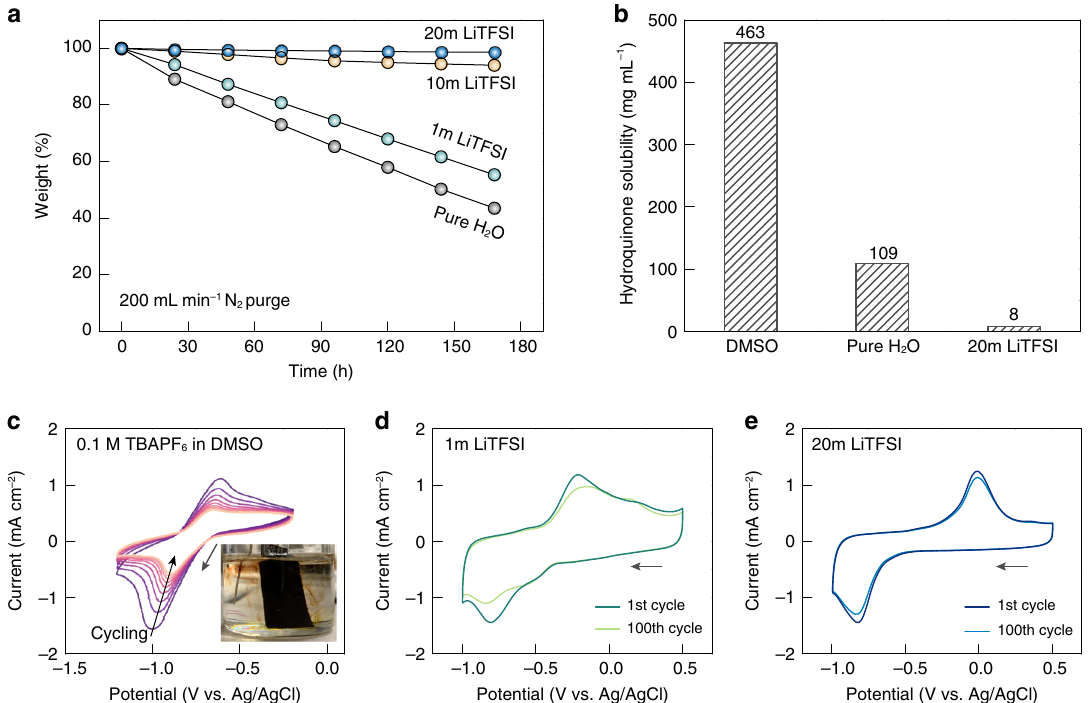
Fig. 4 Physicochemical advantages of salt-concentrated electrolytes for quinone-mediated CO 2 capture. a Weight retention curves of different electrolytes under constant N 2 sparging at a high fl ow rate of 200 mL min − 1 . b Hydroquinone solubility in a representative organic solvent (DMSO), pure water and 20m LiTFSI aqueous electrolyte. c Multicycle CV scans of PAQ-CNT in 0.1 M TBAPF 6 DMSO electrolyte at a rate of 100 mV s − 1 . Inset shows the severe dissolution of PAQ (immobilized on carbon felt) into the electrolyte during electrochemical reduction in a DMSO-based electrolyte. d , e The 1st and 100th CV scans of PAQ-CNT under CO 2 in 1m LiTFSI ( d ) and 20m LiTFSI ( e ) at a rate of 50 mV s − 1 . For all the CV measurements, PAQ was cast on glassy carbon, Pt wire was used as the counter electrode, and Ag/AgCl was used as the reference electrode. Source data are provided as a Source Data fi